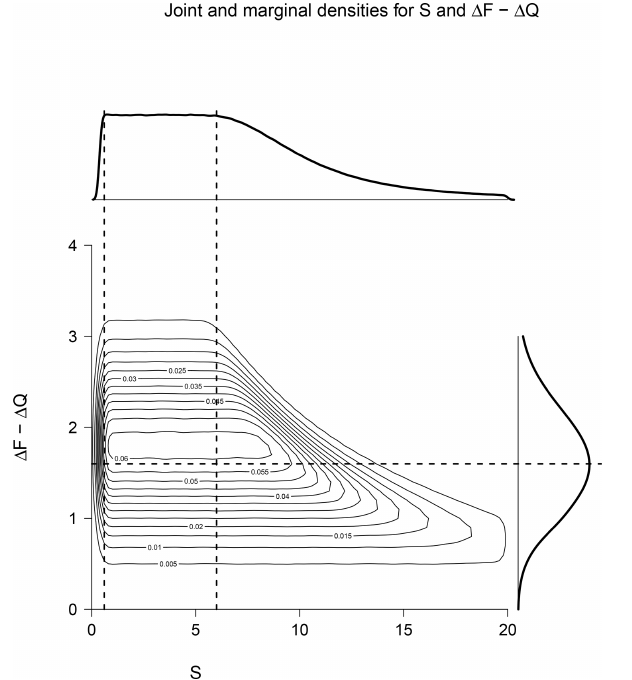
Figure 3. Implicit prior used in the 20th century